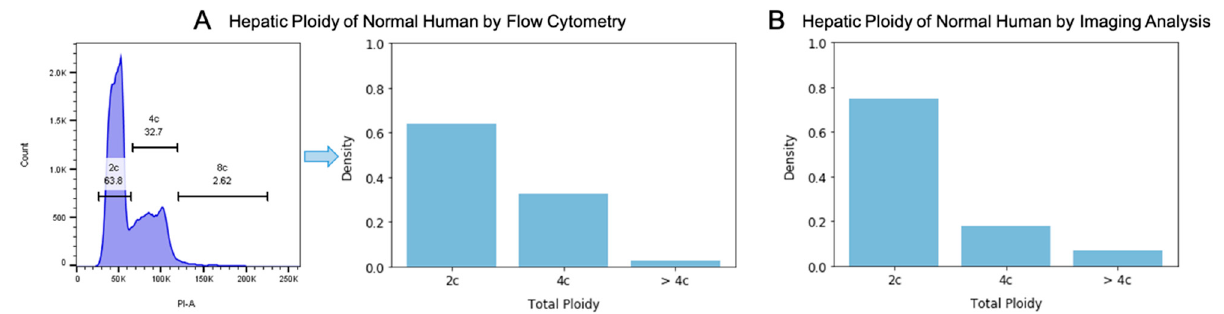
Figure 6. Comparison of the hepatic ploidy quantification result by flow cytometry and imaging analysis. ( A ) The hepatic ploidy profile of a normal human by flow cytometry. ( B ) The hepatic ploidy profile of a normal human by imaging analysis based on the H&E